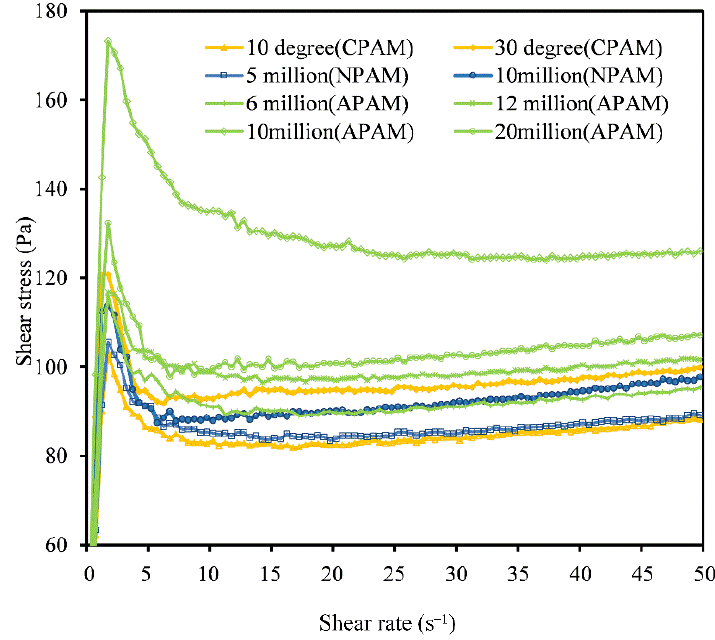
Figure 4. Flow curves of red mud with different ionic types: shear rate vs. shear stress.